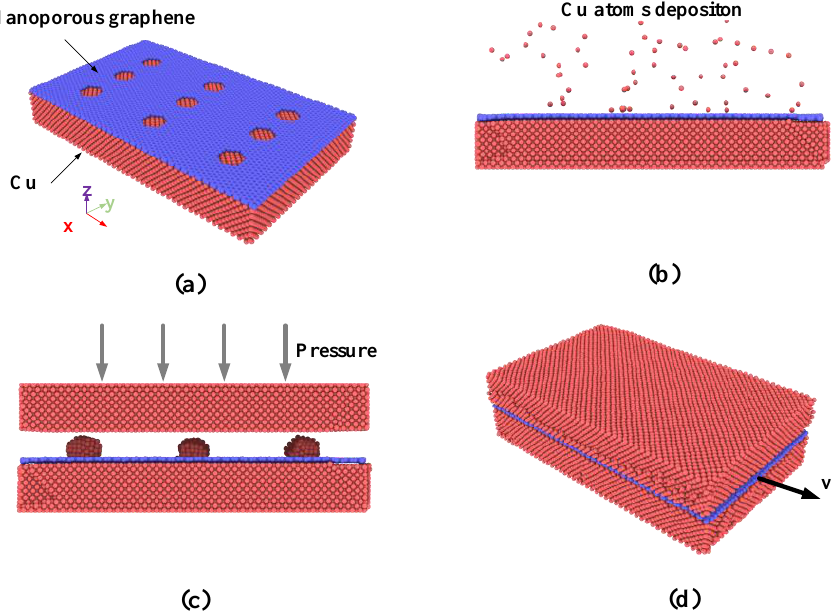
Figure 1. Atomic configurations. ( a ) Cu-nanoporous graphene composite model; ( b ) Cu atoms deposition onto the nanoporous graphene surface; ( c ) Cu-nanoporous graphene-Cu thermocompression bonding; ( d ) Pull-out simulation model.